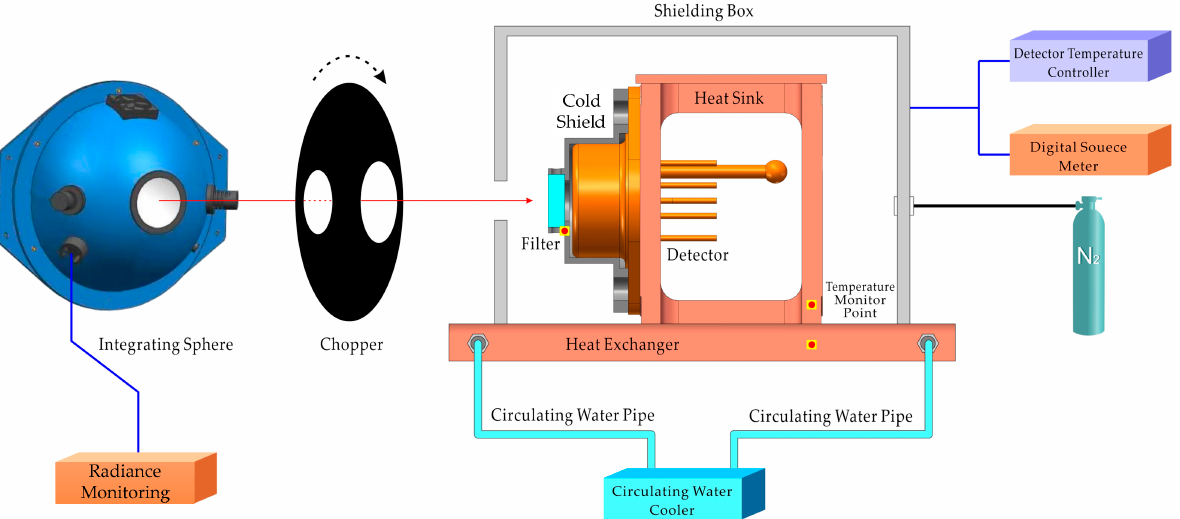
Figure 9. Schematic diagram of the detector-level experiment. The SWIR detector assembly was in-stalled on the heat exchanger, which connected to the circulating water cooler through the circulating water pipe. The integrating sphere was observed through the filter and the window of the shielding box with the chopper.